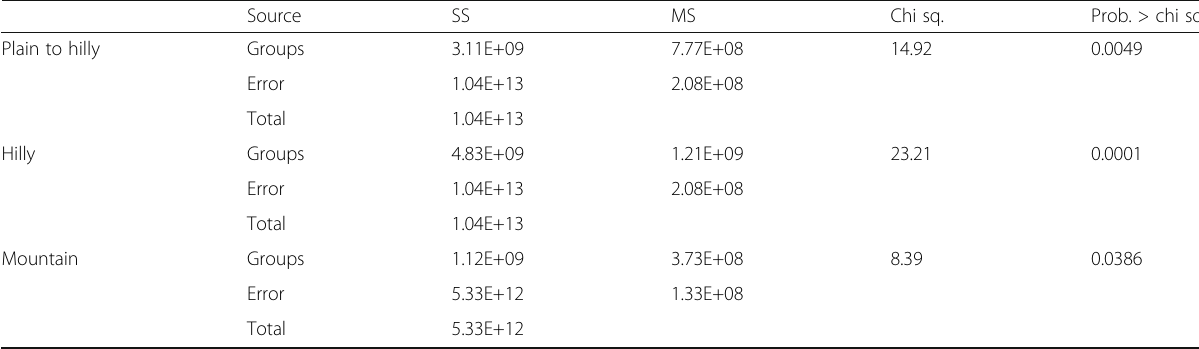
Table 4 Kruskal-Wallis significance tests of mean curvature in each study area based on different land covers with 10,000 sample MS Chi sq. Prob. > chi sq.